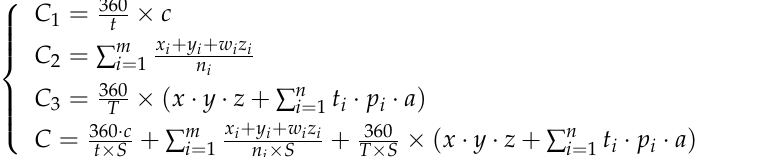
three times, and the average value is taken.